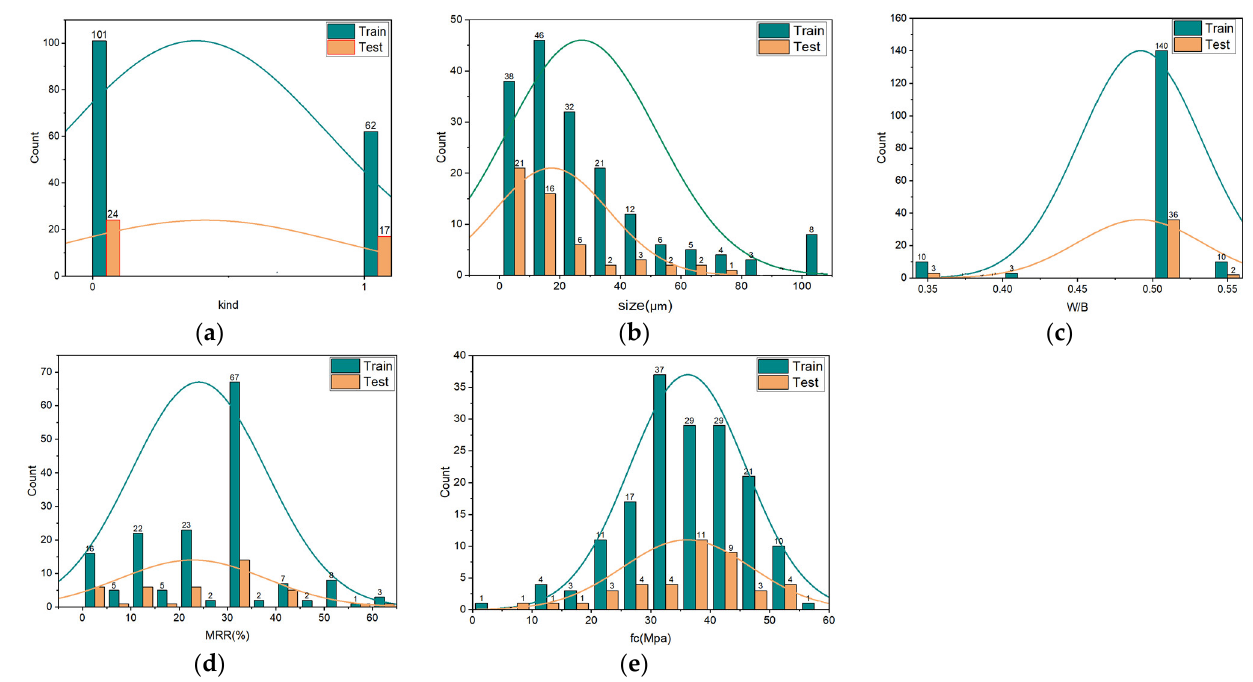
Figure 3. Cumulative plot of the distribution of variables. ( a ) kind; ( b ) size; ( c ) W/B; ( d ) mass replacement rate; ( e ) mortar compressive strength.